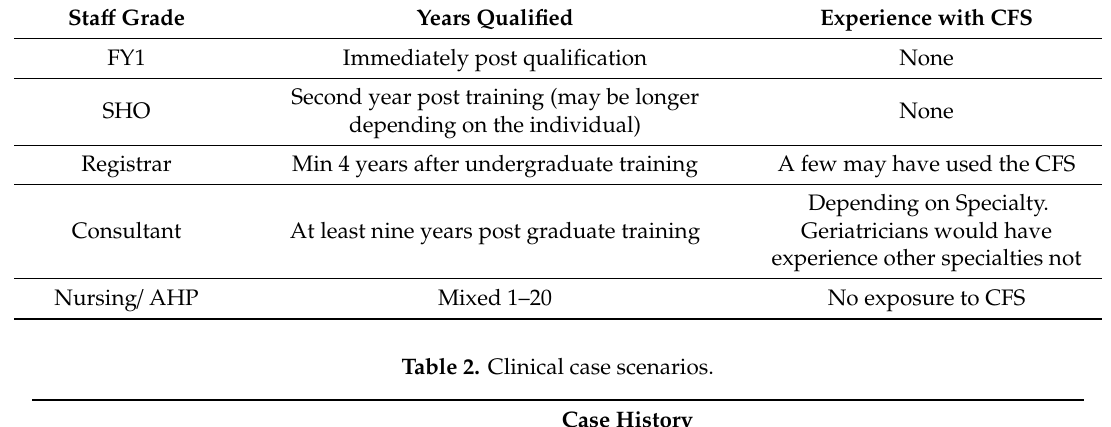
Table 1. Description of sta ff groups and previous experience with the CFS.